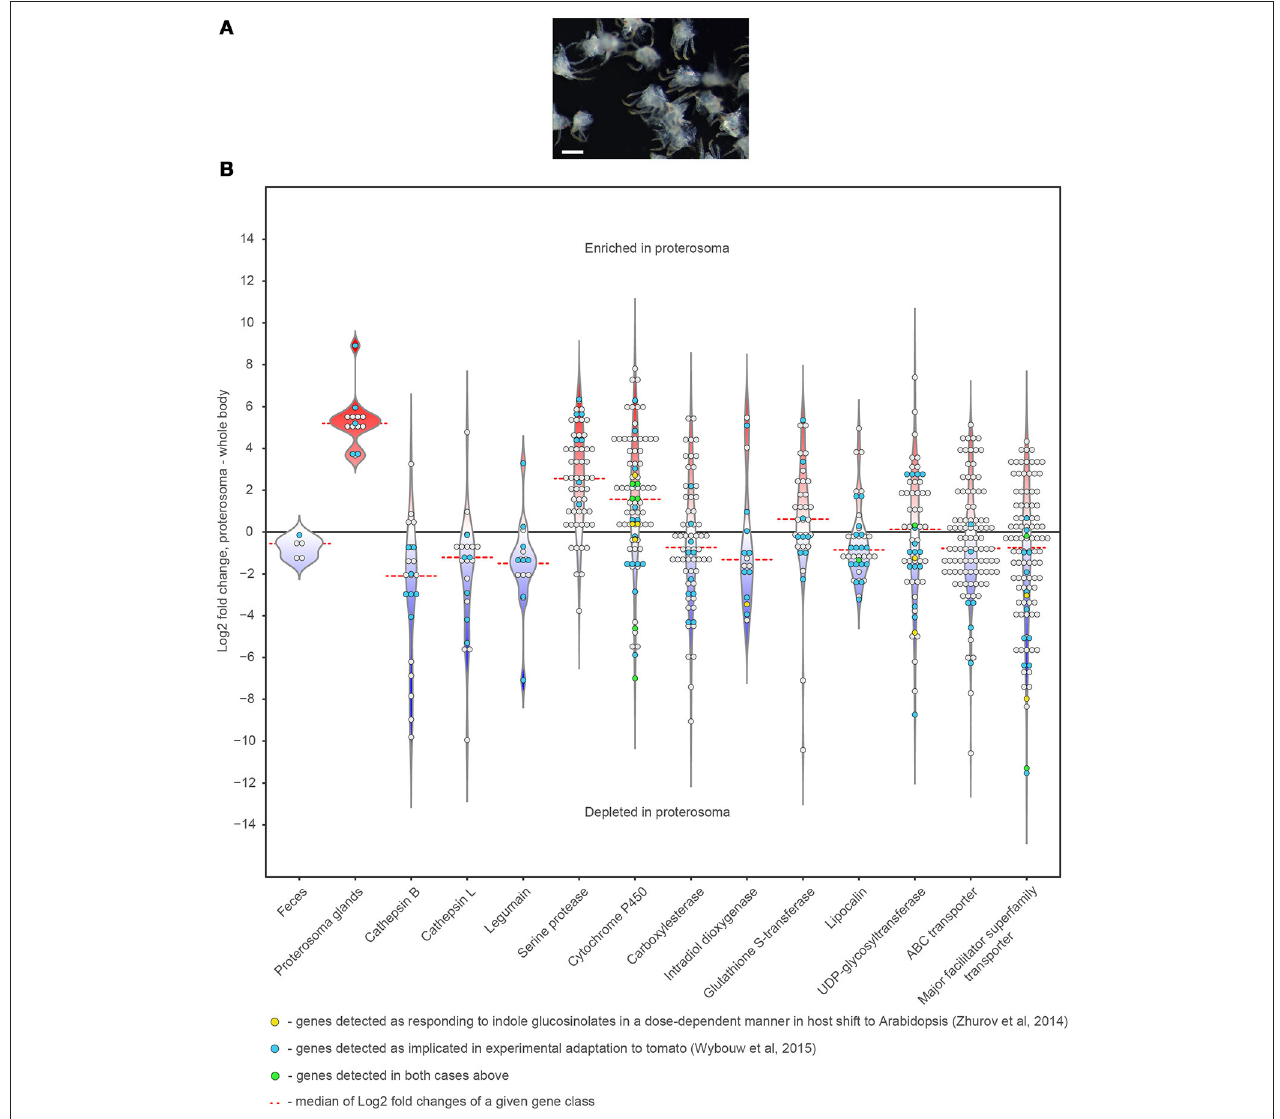
FIGURE 8 | Expression patterns of the digestion/detoxification related genes within spider mite body. (A) Dissected spider mite proterosomas used for the RNA extraction. (B) Violin and dot plots showing distribution of Log2 Fold Changes of expression of genes implicated in digestion and detoxification in mite proterosoma compared to the whole-body levels of expression. Scale bar: 100 µ